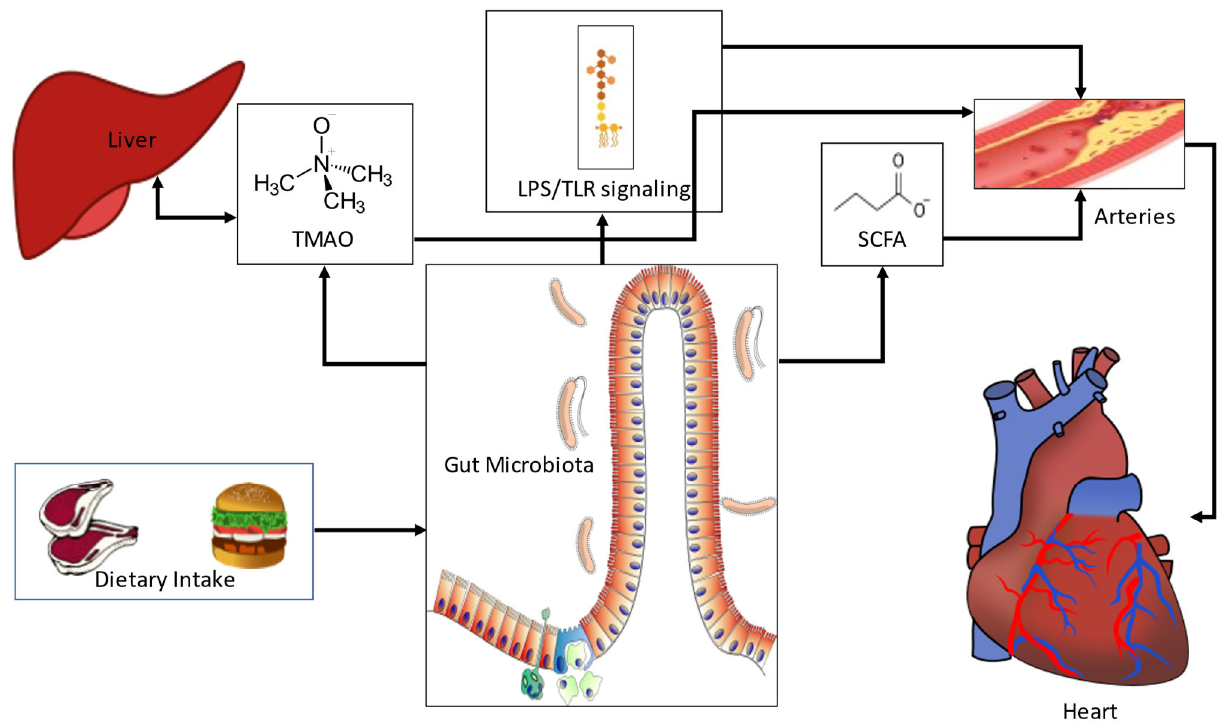
Figure 1. The pathophysiology of gut microbial associations with coronary artery disease. Diet critically shapes the gut microbiota, providing substrates for fermentation. Undigested fiber consumed by bacteria leads to the production of SCFA. Low levels of SCFA have been linked to host inflammation, which may influence atherosclerosis. Many bacterial species also produce TMA using choline as a source. TMA is metabolized to TMAO in the liver by flavin monooxygenases, and is associated with atherosclerosis. Bacterial LPS leaking into the circulation from the gut initiates TLR-mediated systemic inflammation, also linked to atherosclerosis. LPS: Lipopolysaccharide, SCFA: short-chain fatty acids, TLR: toll ‐ like receptor, TMAO: trimethylamine N ‐ oxide.